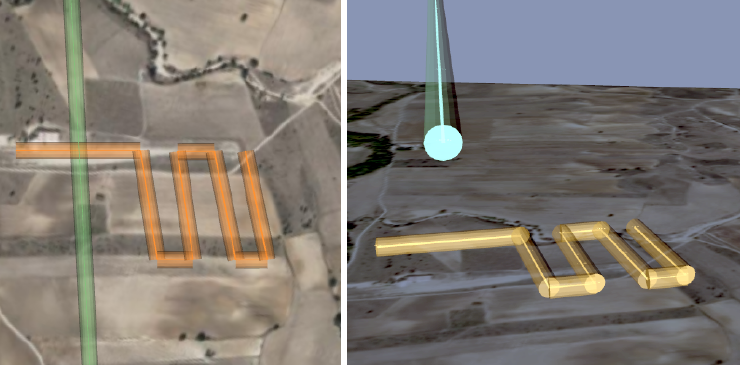
Figure 15. A top ( left ) and a perspective view ( right ) of the initial flight plans in the use case 1. The Operational Volumes are shown for both UAS. There are no conflicts given the UAS 4D